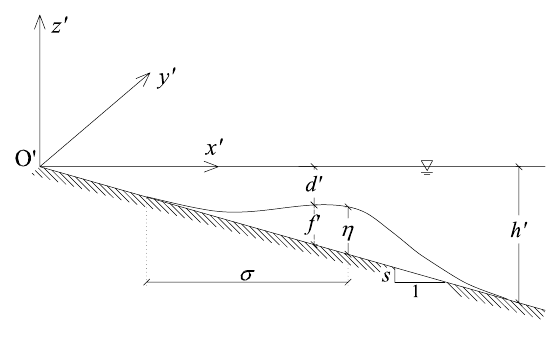
Fig. 1. The fluid domain in physical coordinates; η and σ are re- spectively the slide maximum vertical thickness and characteristic horizontal length, depending on the shape of the landslide.